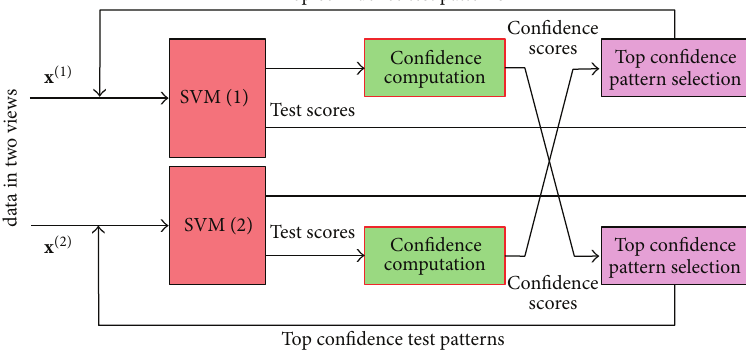
Figure 2: Workflow of the Co-Training